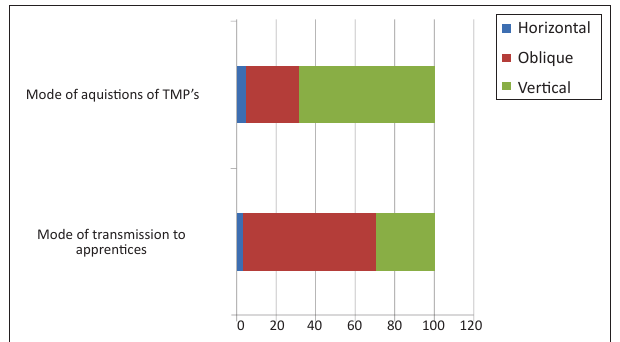
FIGURE 1: A stacked bar graph showing modes of acquisition by TMPs and modes of transmission to apprentices.